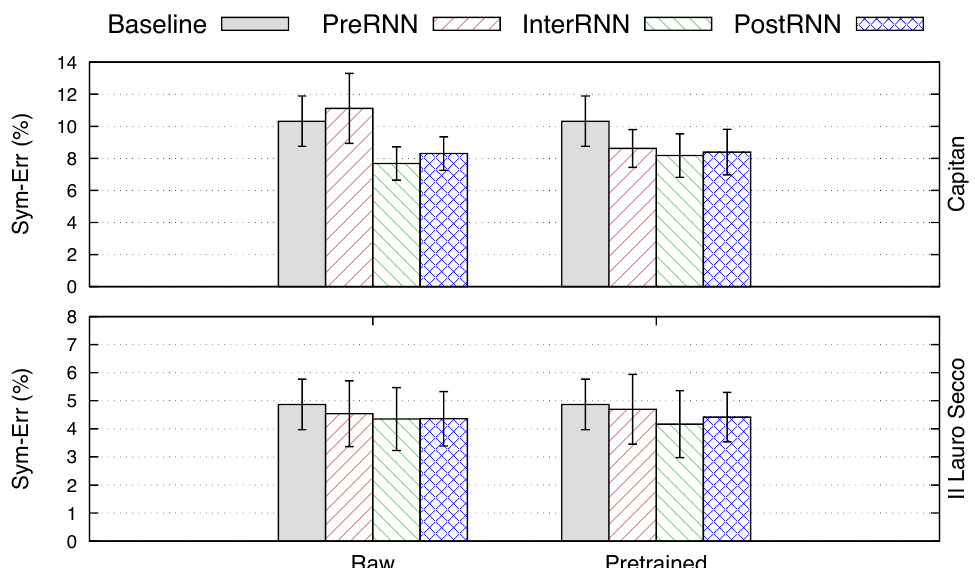
Figure 5. Comparison of the base neural model and the different architectures proposed for the Σ T vocabulary case in terms of the Symbol Error Rate (Sym-ER (%)) and their respective standard deviations. Pretrained and raw denote the cases in which shape and height branches have been trained or not before considering the joint model, respectively.